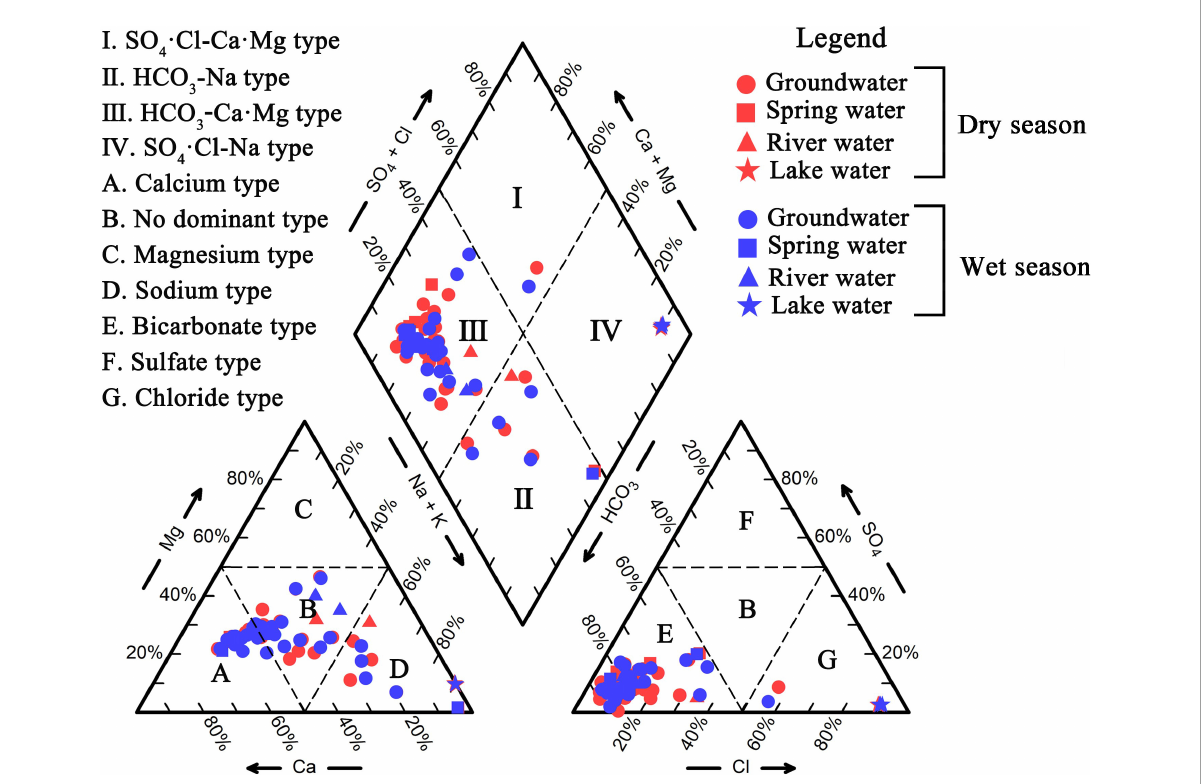
FIGURE3 Piper diagram of hydrochemistry in the Daihai Lake